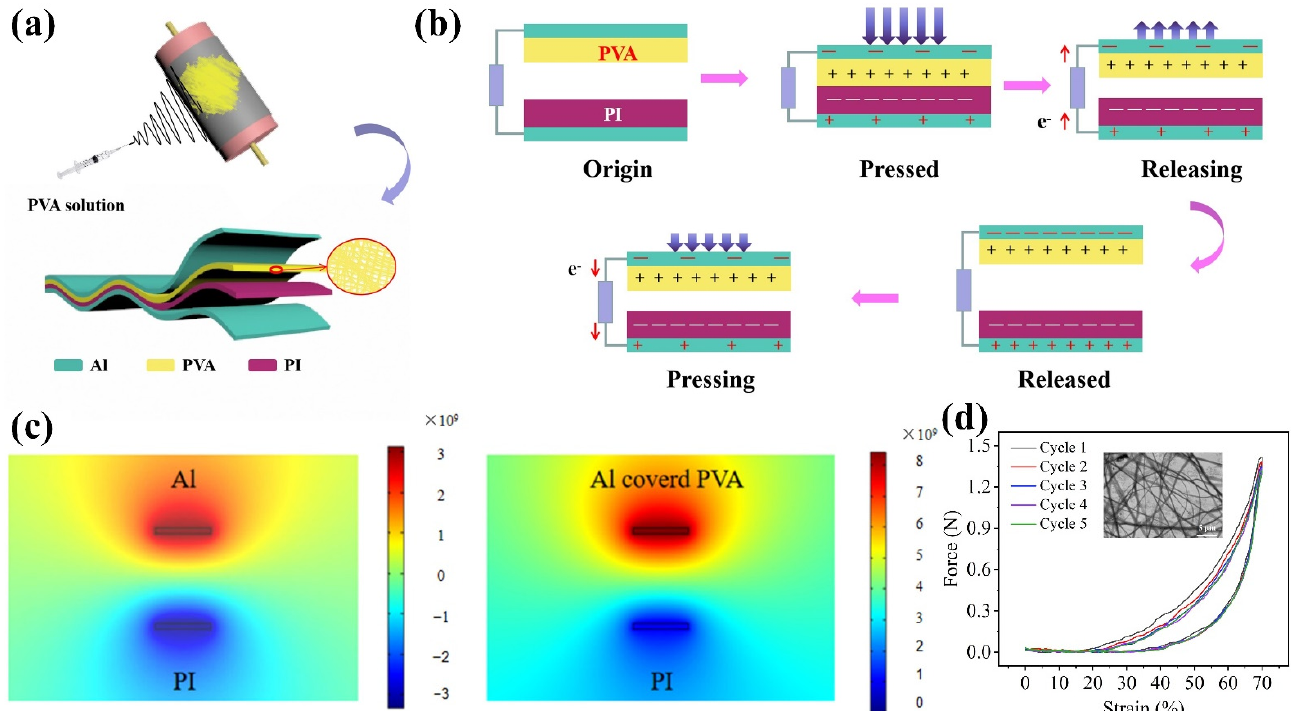
Figure 2. ( a ) Structure of Al-PVA/PI TENG and manufacturing process. ( b ) Schematic diagram of operating principle of generator. ( c ) Effect of TENG friction potential. ( d ) Hysteresis cycle of PVA on TENG surface.